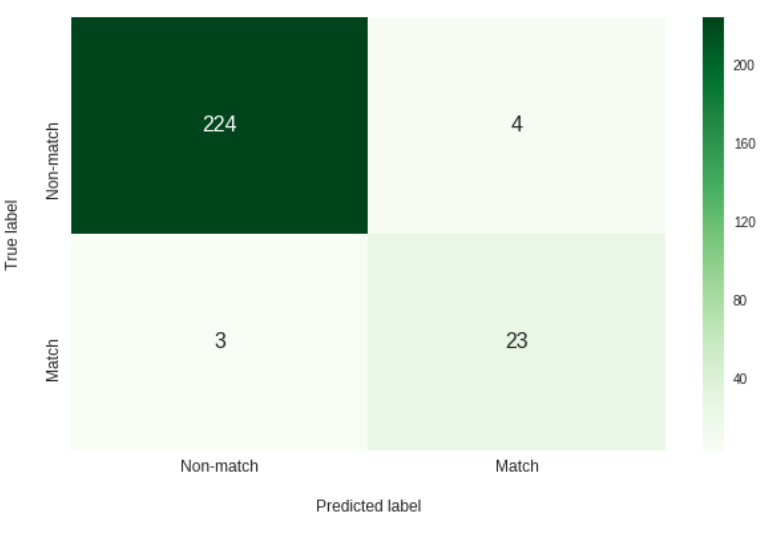
Figure 2: Figure generated by code